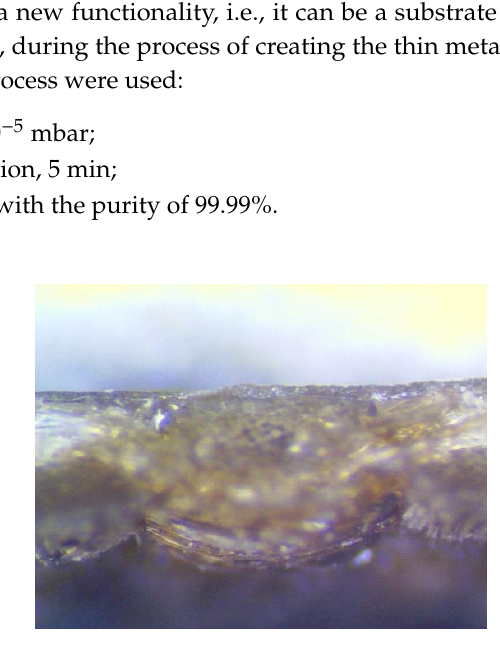
Figure 2. A cross-section of the tested textile composite.